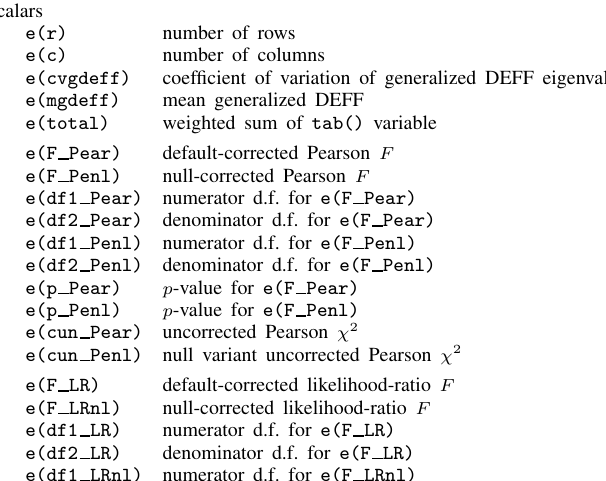
svy: tabulate twoway — Two-way tables for survey data